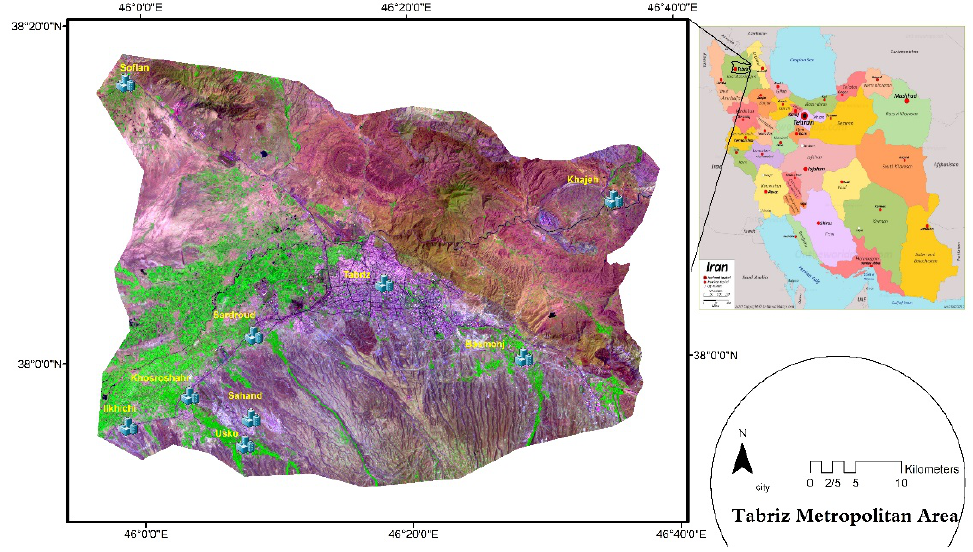
Figure 1. Study area: Tabriz Metropolitan Area, East Azarbiajan, Iran.